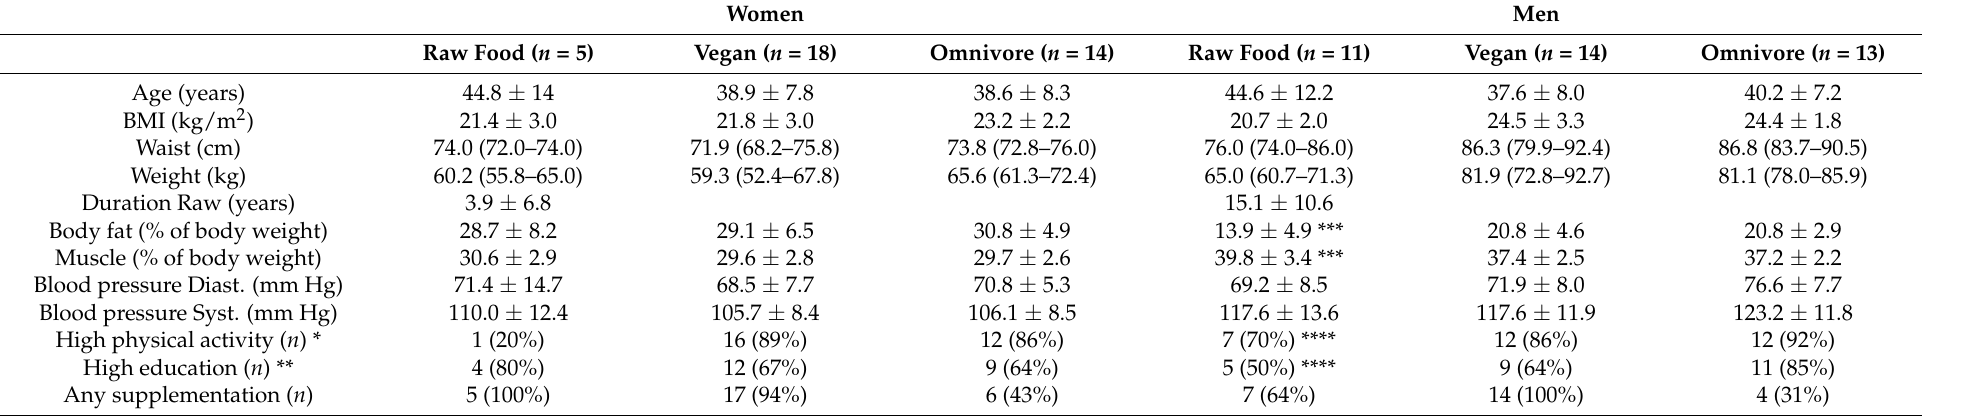
Table 2. Characteristics of study populations: women and men of raw food eaters, RBVD vegans and RBVD